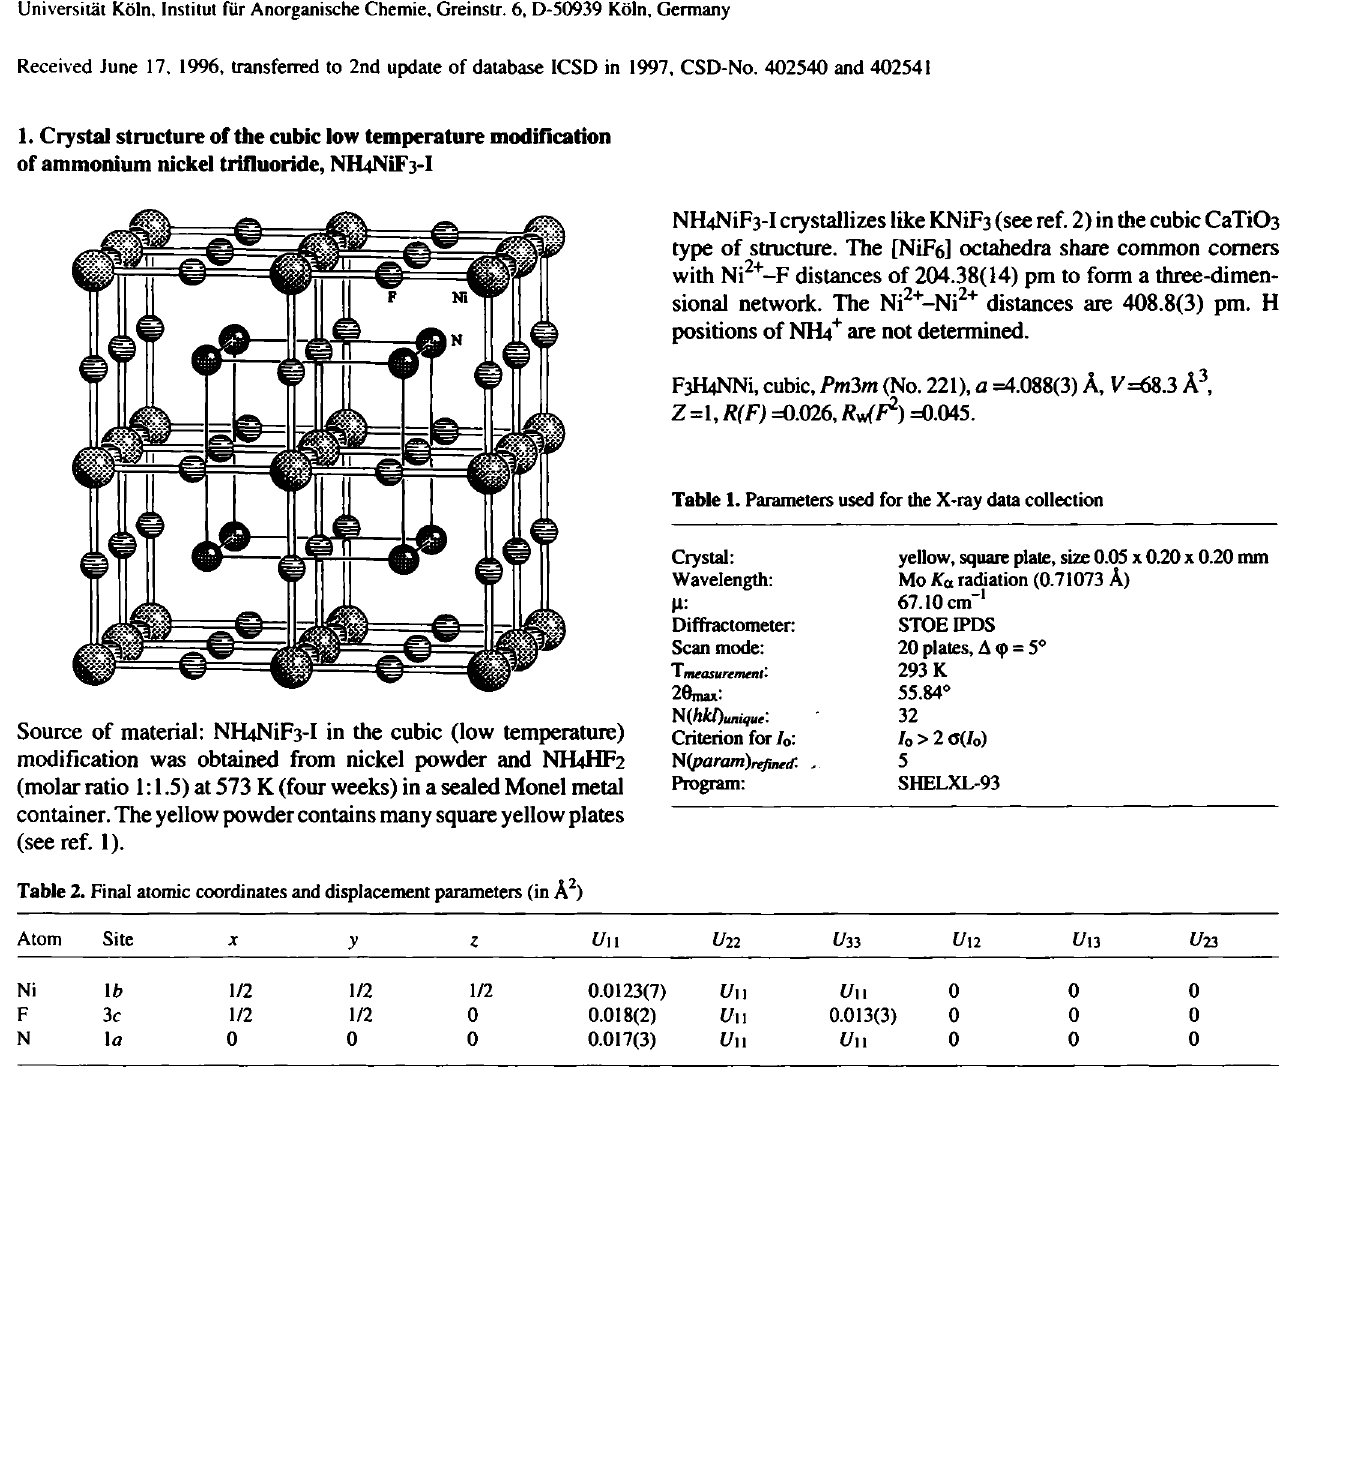
Table 2. Final atomic coordinates and displacement parameters (in Â 2 )